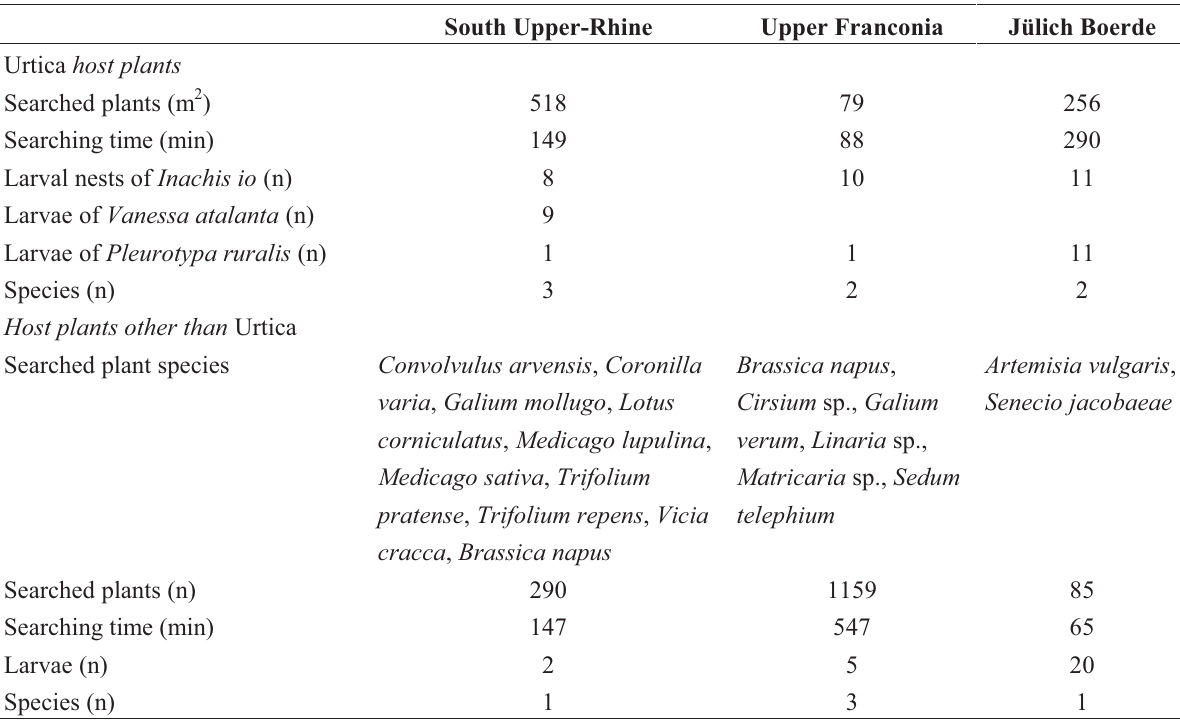
Table 5. Visual search of Lepidoptera larvae in the three study regions (excluding blackthorn bushes). Note that the regions differ in sampling intensity (see Table